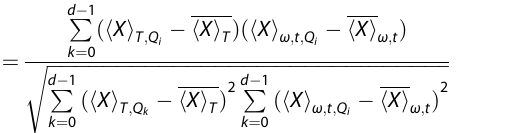
at τ = 50 μ s by t and a T or T